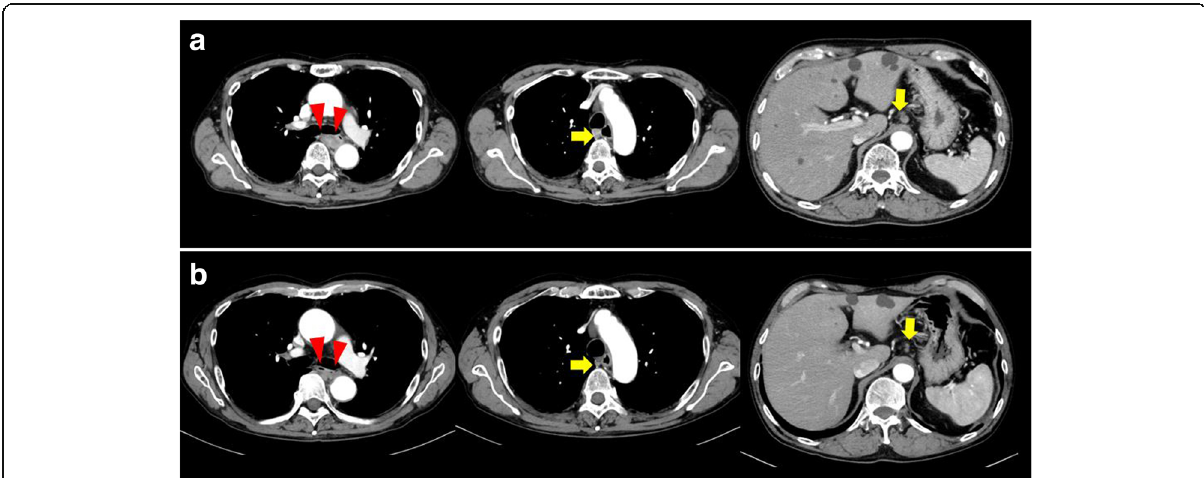
Fig. 4 Computed tomography findings. a Before preoperative chemotherapy, a tumor was observed in the middle of the esophagus (red arrows) with swollen lymph nodes in the mediastinum and around the cardia (yellow arrows), but there was no distant metastasis. b After preoperative chemotherapy, the tumor (red arrows) and swollen lymph nodes in the mediastinum and around the cardia (yellow arrows) were reduced